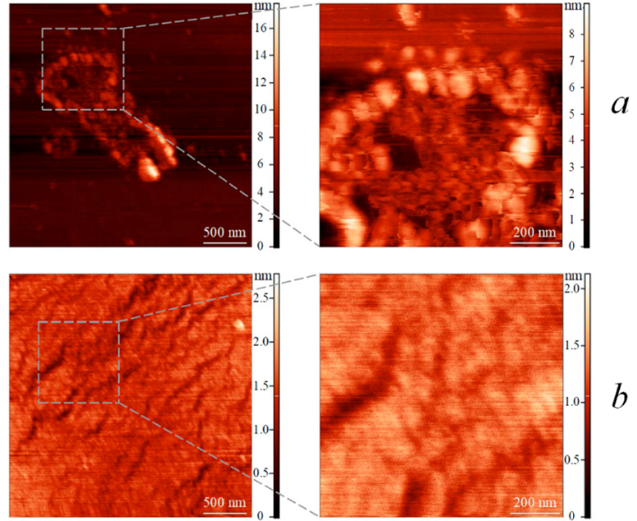
Figure 6. AFM images of the LB films of functional polymer ( a ) and block copolymer ( b ) at transfer pressure of 12 mN/m (10 μ L) and 25 mN/m (30 μ L), respectively (T = 21 °C, pH = 7.0).